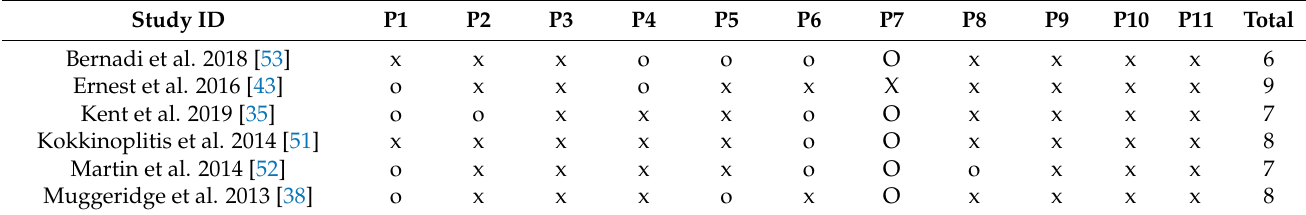
Table A1. PEDro scores for the 17 included